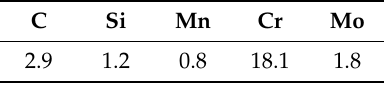
Table 1. Composition (wt